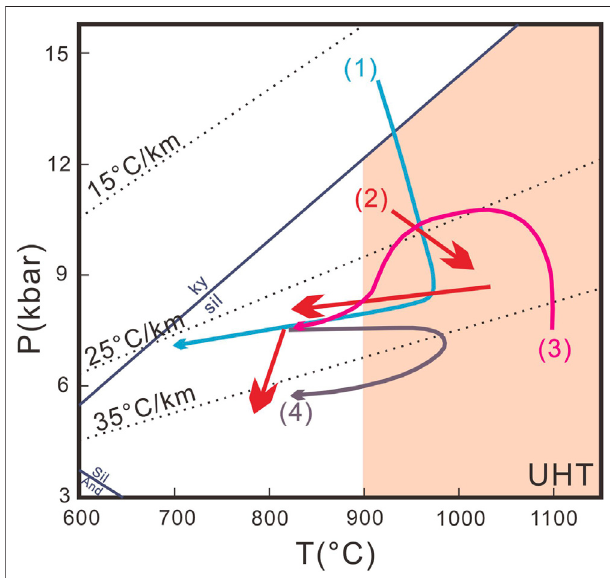
FIGURE 2 | Previously reported P – T paths of UHT granulites in the KhondaliteBelt.(1)isfromLiandWei(2016),(2)isfromLiandWei(2018),(3)is from Santosh et al. (2012) and (4) is from Yang et al.